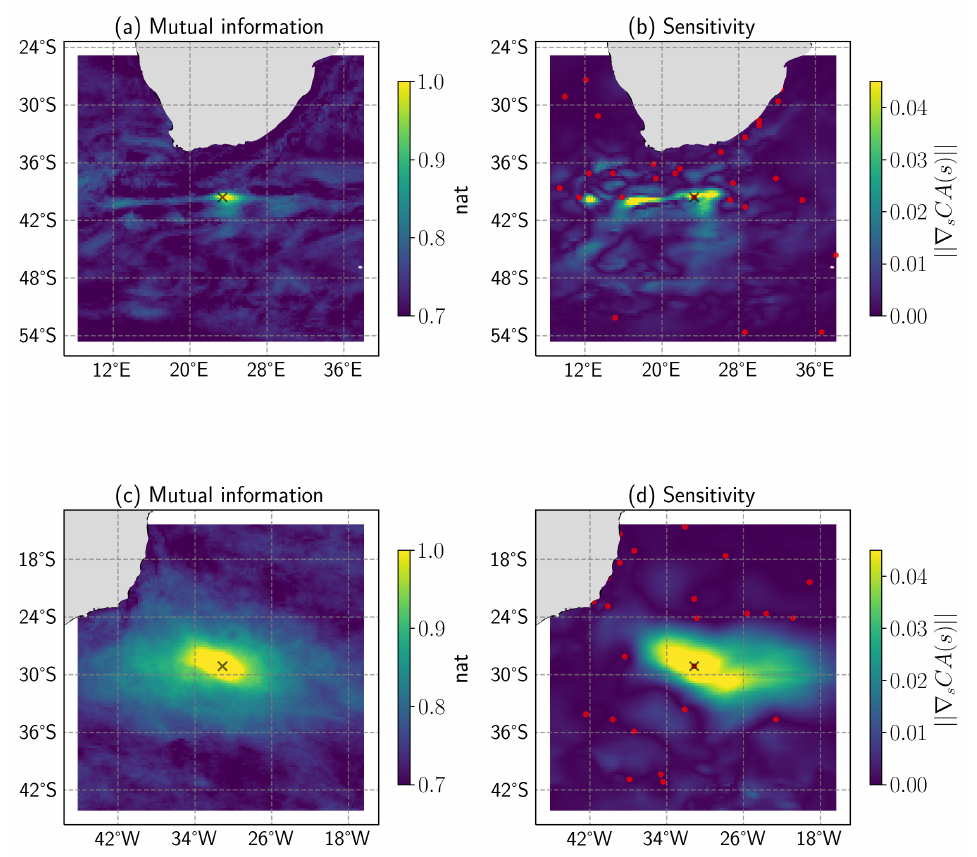
Figure 18. Mutual information ( a , c ) and sensitivity of the Concrete Autoencoder ( b , d ) fields for the point at the front of Agulhas and Antarctic Circumpolar currents ( a , b ) and for the point at the Brazil current ( c , d